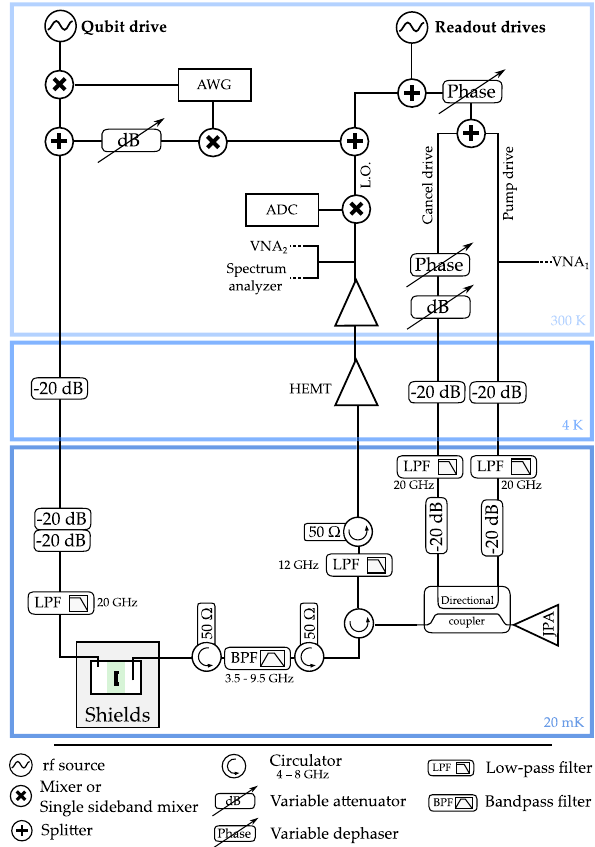
FIG. 7. Schematic of the experimental setup. Abbreviations: arbitrary waveform generator (AWG), low-pass filter (LPF), band-pass filter (BPF), local oscillator (LO), vector network analyzer (VNA), and analog to digital converter at the left and right nodes of the circuit denoted by Φ 1 and Φ 2 , respectively [cf. Figs. 2(c) and 2(d)]. The kinetic